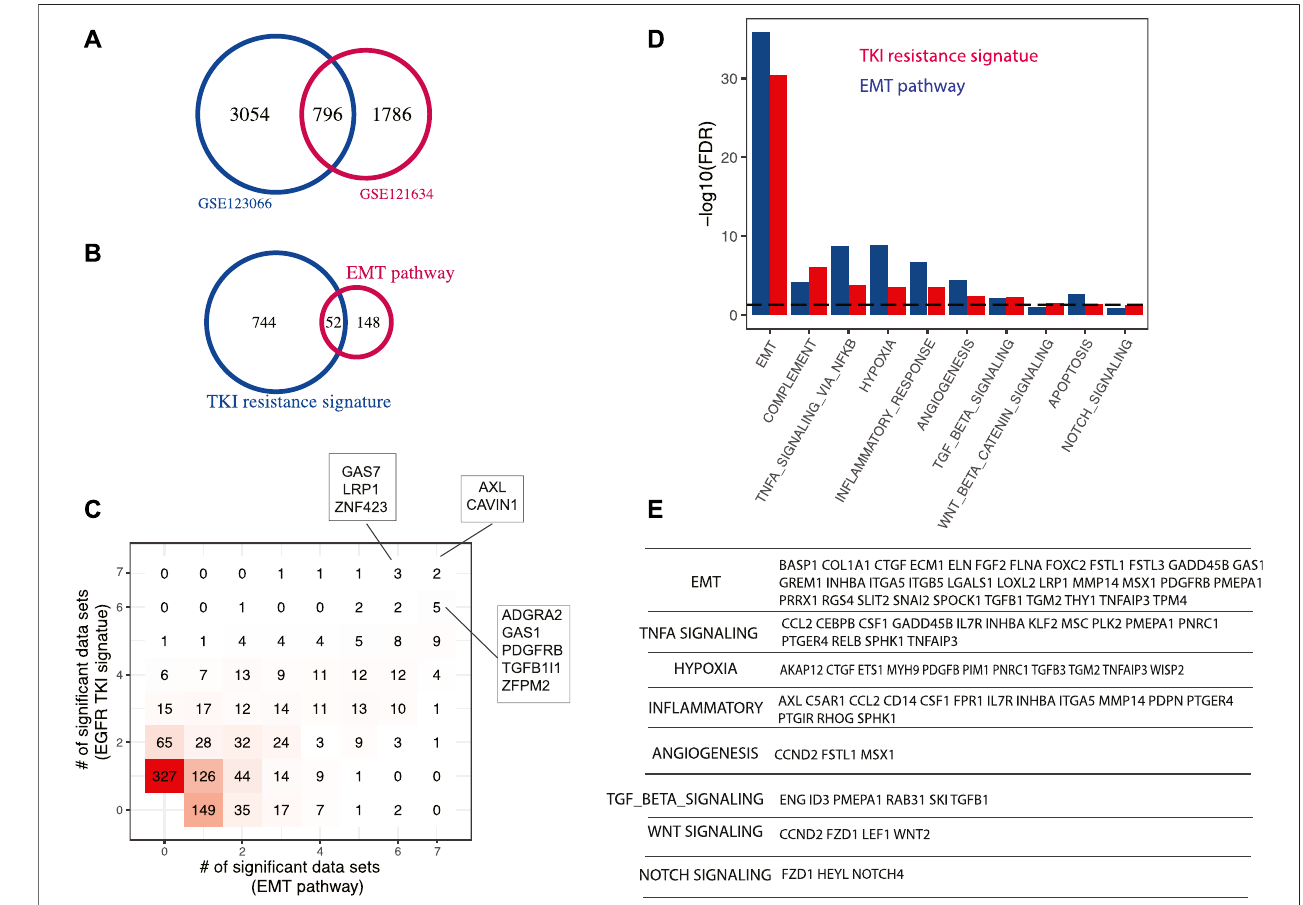
FIGURE 4 | Master regulators driving EGFR-TKI resistance. (A) A new EGR-TKI resistance signature. EGFR-TKI resistant samples were compared to parental cell lines and the signature was de fi ned as the genes that were signi fi cantly upregulated in two independent datasets. (B) Enrichment of EMT pathway in EGFR-TKI resistance signature. (C) Comparison of master regulators predicted with EGFR-TKI signature and EMT pathway signature. Both signatures were tested across seven LUAD gene expression datasets and master regulators were identi fi ed with a p -value cutoff of 0.01 ( Section 2 ). The results were summarized to show how many times a master regulator was identi fi ed and represented as a 2D histogram. (D) Pathways enriched in top-ranking master regulators predicted using TKI resistance signature or EMT pathway signature. (E) Selected master regulators grouped by enriched pathways. To avoid redundancy, a gene in multiple pathways was only assigned to the one with higher signi fi